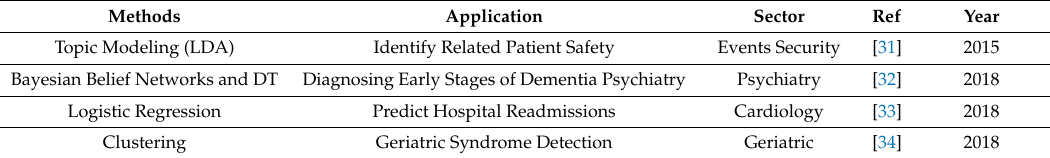
Table 3. Example of mixed approach case studies